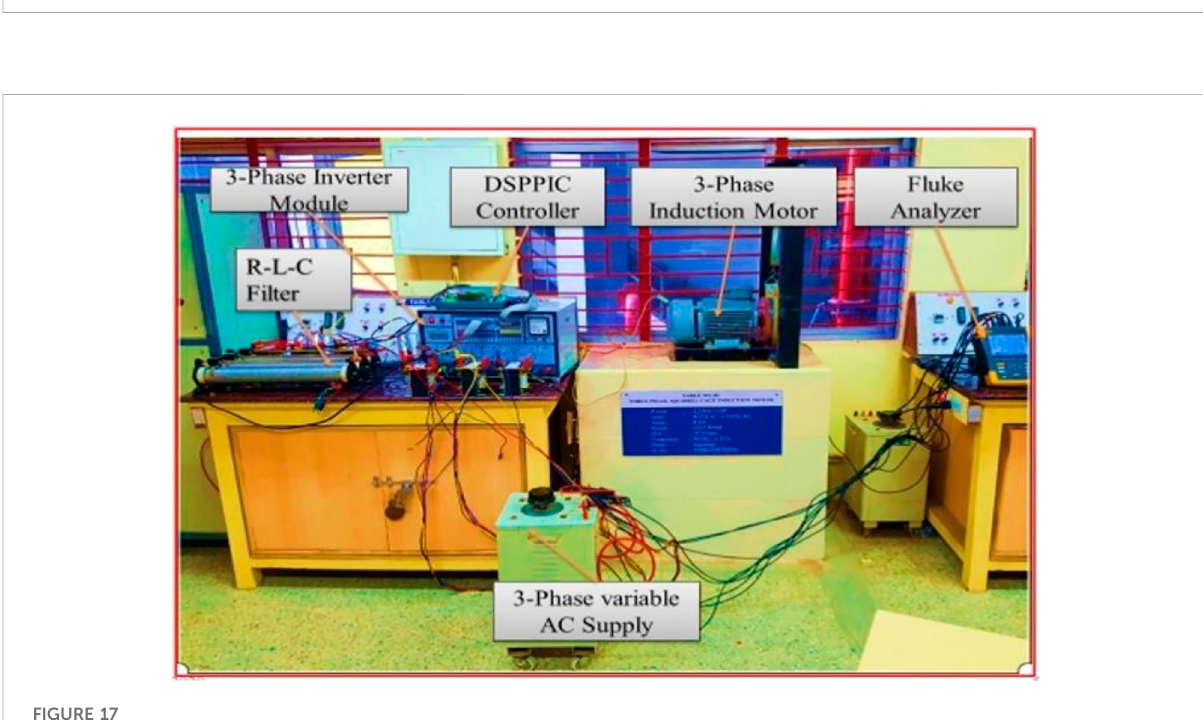
FIGURE 17 Experimental setup of a passive fi lter.